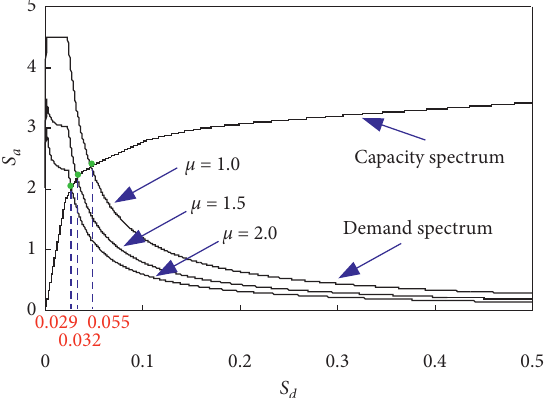
Figure 7: Analysis process of the simplified prediction method corresponding to PGA �